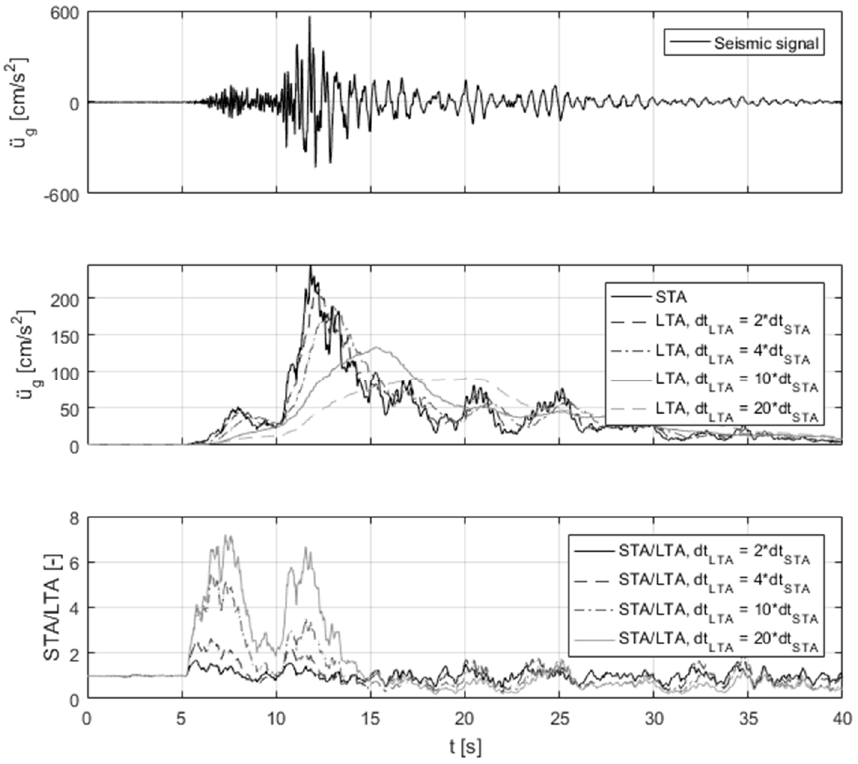
Figure 1. Short-time average through the long-time average ratio (STA/LTA) algorithm.